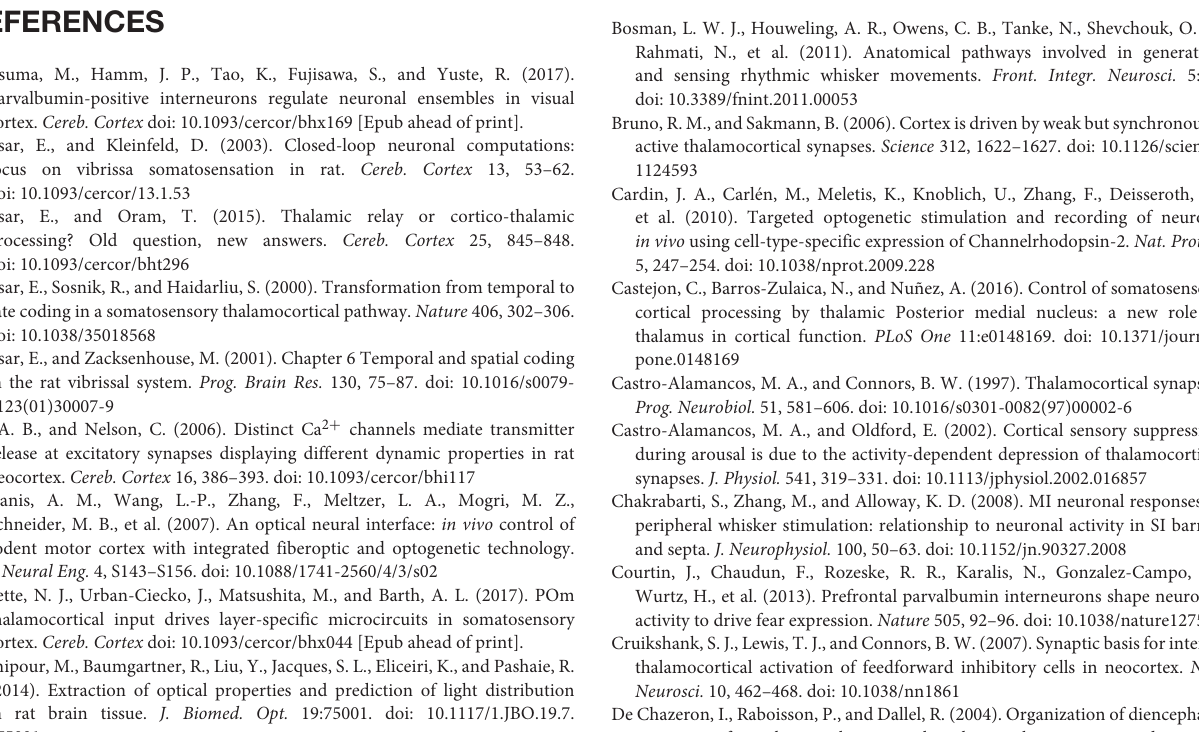
FIGURE S1 | Effect of muscimol application in Po and ventral lateral (VL) thalamic nucleus responses. (A) Muscimol injection into Po nucleus decreases responses in the same nucleus. Representative SEP1 trace recorded in Po nucleus to whisker pad stimulation (20 ms duration; 1 Hz; 100 stimuli). Responses in control condition (before; gray dashed line) and after muscimol injection (0.1 µ l; 1 mM) into Po. Note that whiskers-evoked responses decreased 10 and 20 min (blue and purple lines) after muscimol injection into Po. (B) Responses in the ventral lateral thalamic nucleus are not modified by muscimol injection in Po nucleus. Representative case traces of VL responses to M1 cortex electrical stimulation (0.1 ms; 20–50 µ A; 100 stimuli) before; (gray dashed line) and after muscimol injection (0.1 µ l; 1 mM) into Po (colored lines). Note that responses were not decreased by the muscimol injection. FIGURE S2 | Po cell populations transfected with ChR2-eYFP viral vector. (A) Camera-lucida reconstruction of the complete extent of the transfected cell population (green area) in the case photographed in Figure 5 . (B–E) Images from the center of the transfected cell population as seen on coronal sections lightly counterstained with thionin. Distance to bregma is indicated in the right upper corner. Bars: A = 1 mm, B–E = 500 µ m. Additional abbreviations: LP, Lateral posterior thalamic nucleus; LPMR, Mediorostral part of LP nucleus; LPLR, Laterorostral part of LP nucleus; DLG, dorsal lateral geniculate nucleus; PF, Parafascicular thalamic nucleus. FIGURE S3 | Transfected Po axon varicosities form frequent close appositions with parvalbumin (PV)-expressing interneurons. High-resolution 3D-confocal analysis of double-labeling in L3 of M1wk. The eYFP fluorescence image (green) and PV immunofluorescence image (red) are overlaid. For each field, three orthogonal views (a direct image and two Z-stack reconstructions, not corrected for shrinkage) are illustrated. (A–C) Three appositions (arrowhead) between an eYFP-expressing Po axon varicosity and a PV-immunostained interneuron soma. (D–F) Three appositions (arrowhead) between an eYFP-expressing Po axon varicosity and PV-immunostained dendrites. A higher-magnification detail of the apposition is shown in the lower left corner insets. Bars: A–F = 5 µ m; D–F Insets = 1 µ